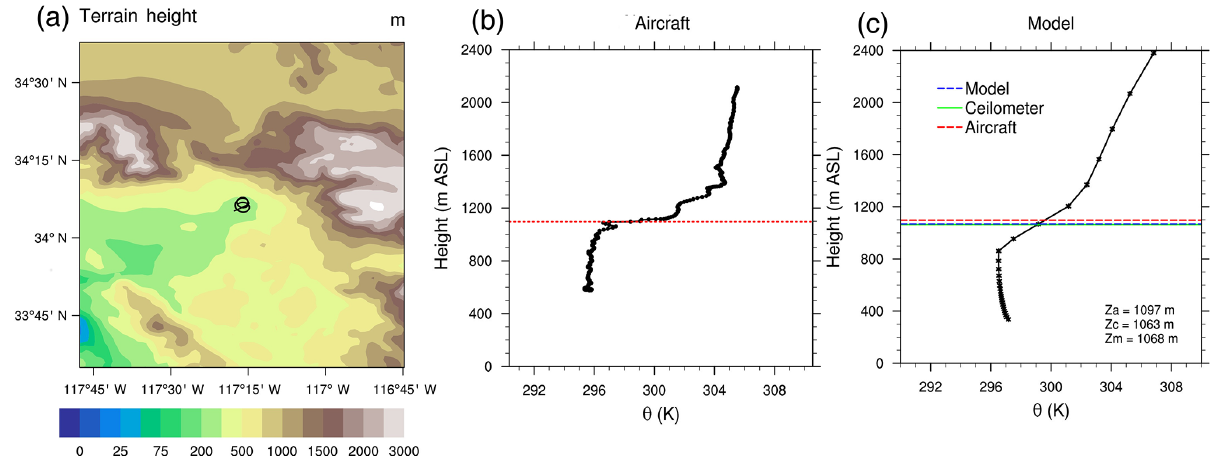
Figure 2. A case selected on 19 May 2010 at 1225PST. (a) Location of the vertical profile flown by the CalNex aircraft and the neighbouring terrain heights (units: m). (b) In situ potential temperature profile measured by the aircraft. The red dashed line at ∼ 1100m is the PBL height calculated based on the vertical gradient of potential temperature (K). (c) Modelled potential temperature profile from the MYNN_UCM_d02 configuration. The red dashed line is the aircraft-determined PBL height ( Z a inma.s.l.). The solid green line is the PBL height measured by the Caltech ceilometer ( Z c inma.s.l.). The blue dashed line is the modelled PBL height ( Z m inma.s.l.), almost identical to the green line.